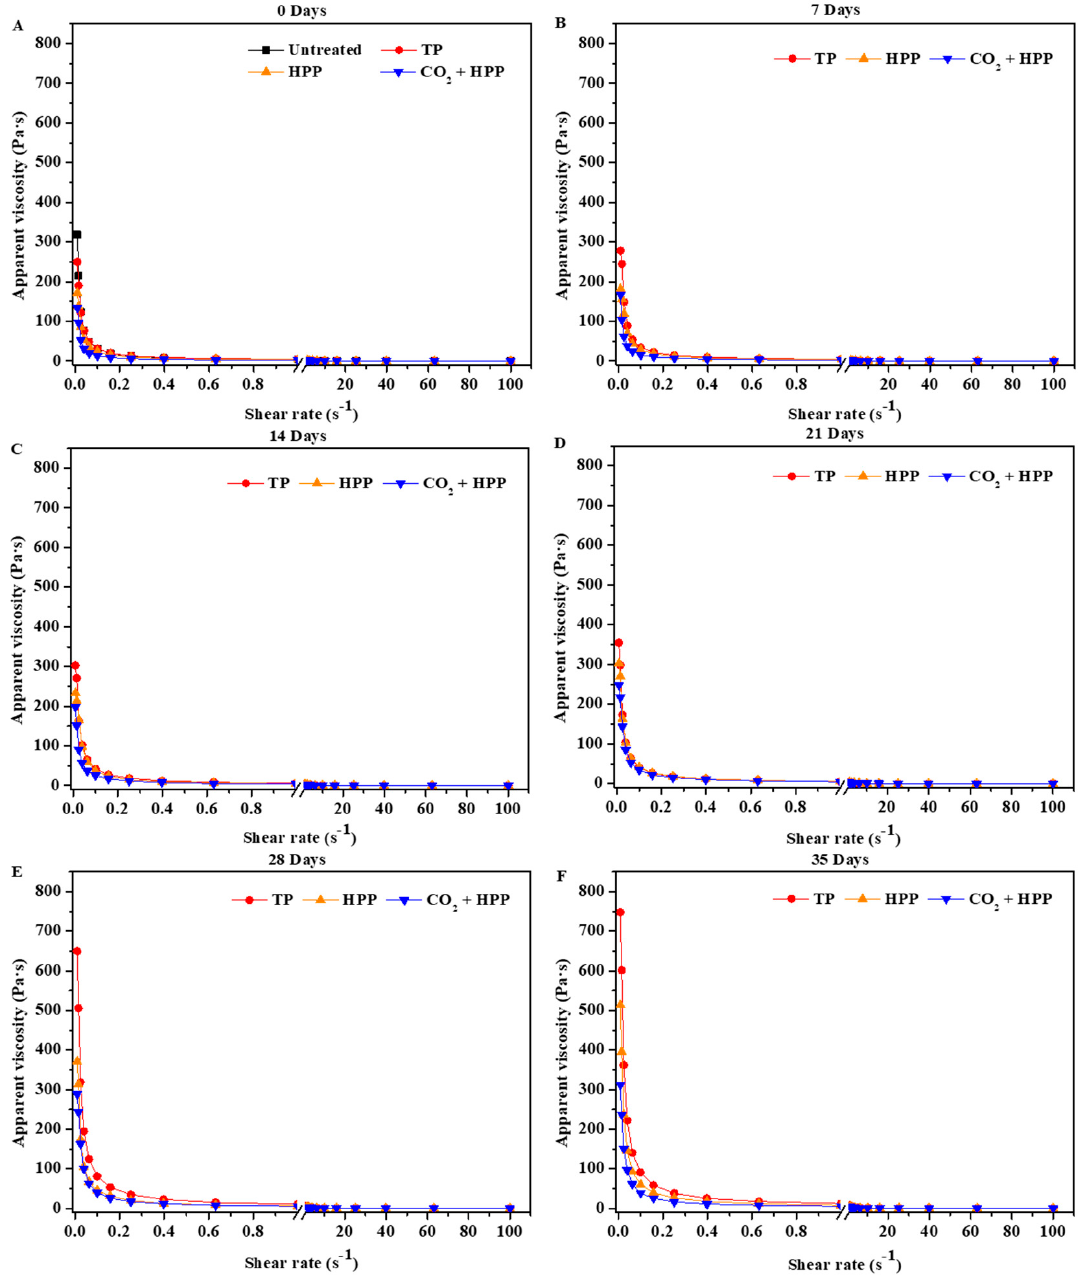
Figure 3. Changes in apparent viscosity of TP—(95 °C, 60 min), HPP—(600 Mpa), and (CO 2 + HPP)— treated DFP (600 Mpa) during storage. ( A – F ) present 0, 7, 14, 21, 28, and 35 days, respectively.